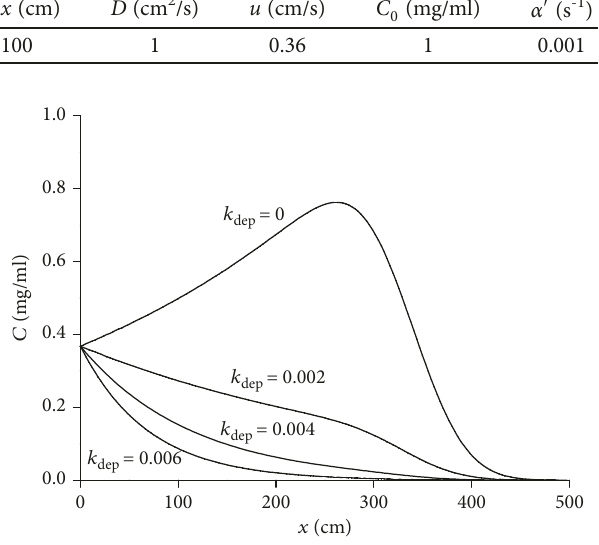
Figure 6: Relationship between particle concentration and distance for four deposition rate coe ffi cients, using parameters given in Table 5. Table 5: Model parameters for simulations shown in Figure